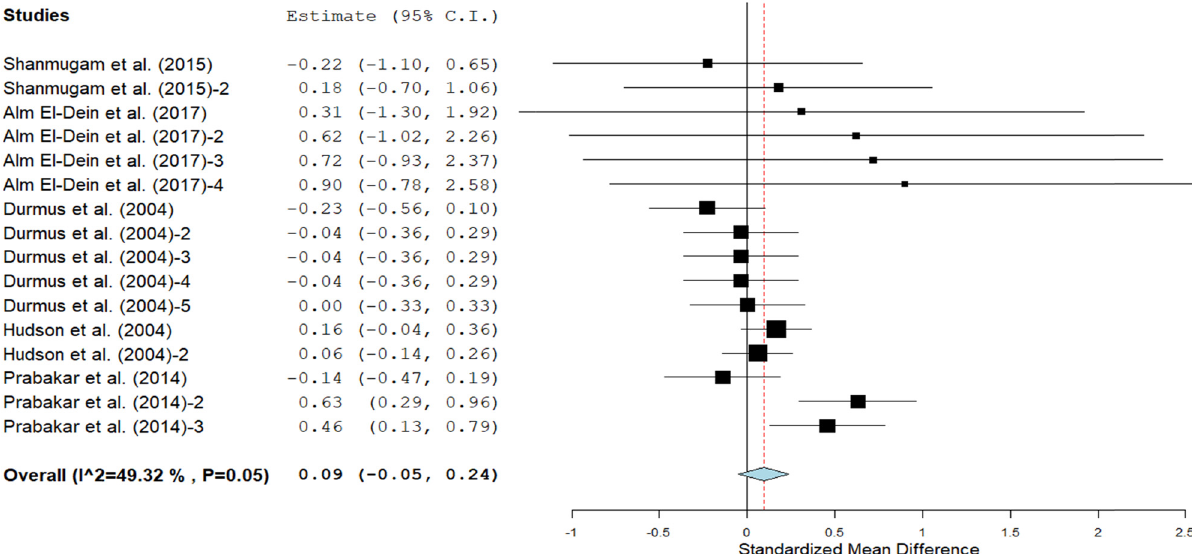
Figure 9: Impact of dietary zinc additive on hatchability in breeder hens. The thick vertical line is the line of no e ff ect ( i.e. SMD = 0 ) . Points to the left of this thick vertical line connote a decrease in egg hatchability, while points to the right depict an increase in egg hatchability. The dotted line shows the overall SMD. The result is considered signi fi cant the 95% CI of the overall SMD did not include